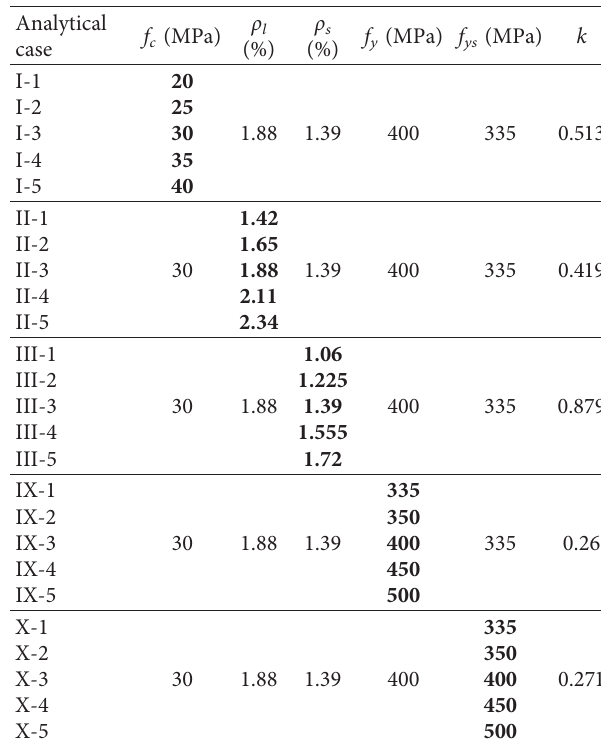
Table 6: Slope k fitted in analytical cases by linear regression.